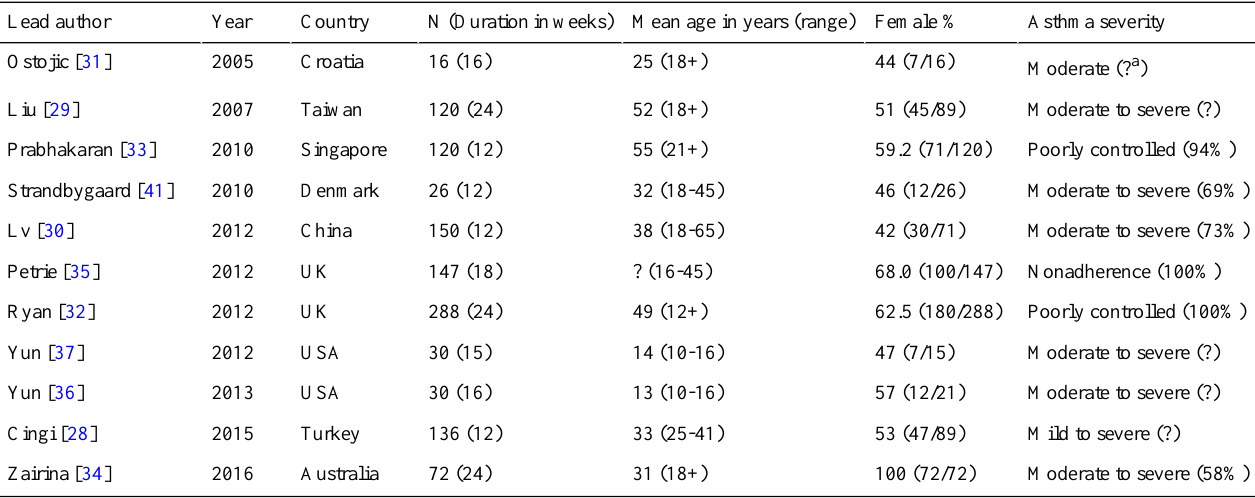
Table 1. Study population characteristics of included studies.